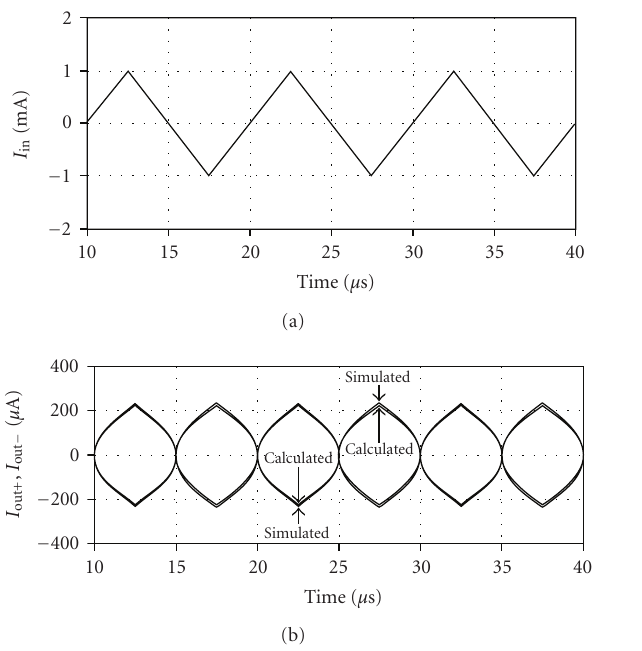
Figure 5: Operation of circuit for the 100kHz input triangular signal: (a) input waveform; (b) output waveforms.